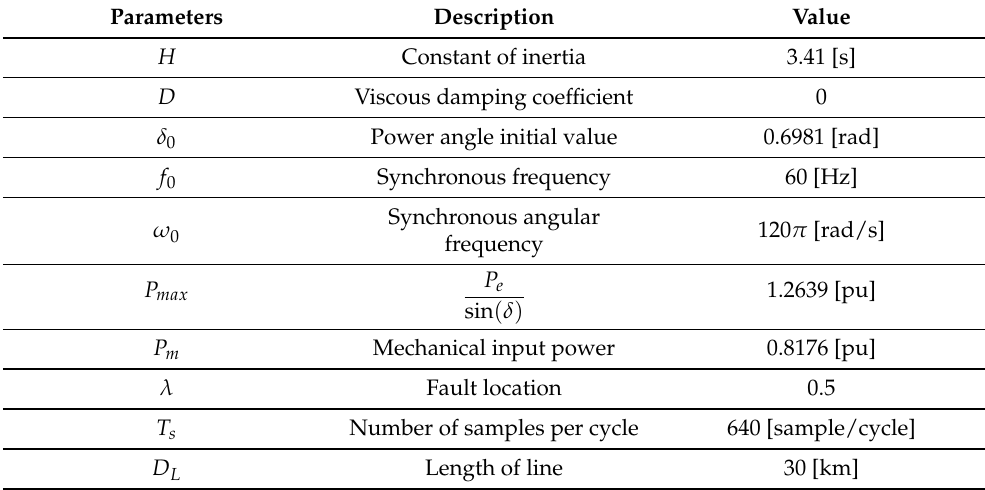
Table 1. Parameter values. Parameters